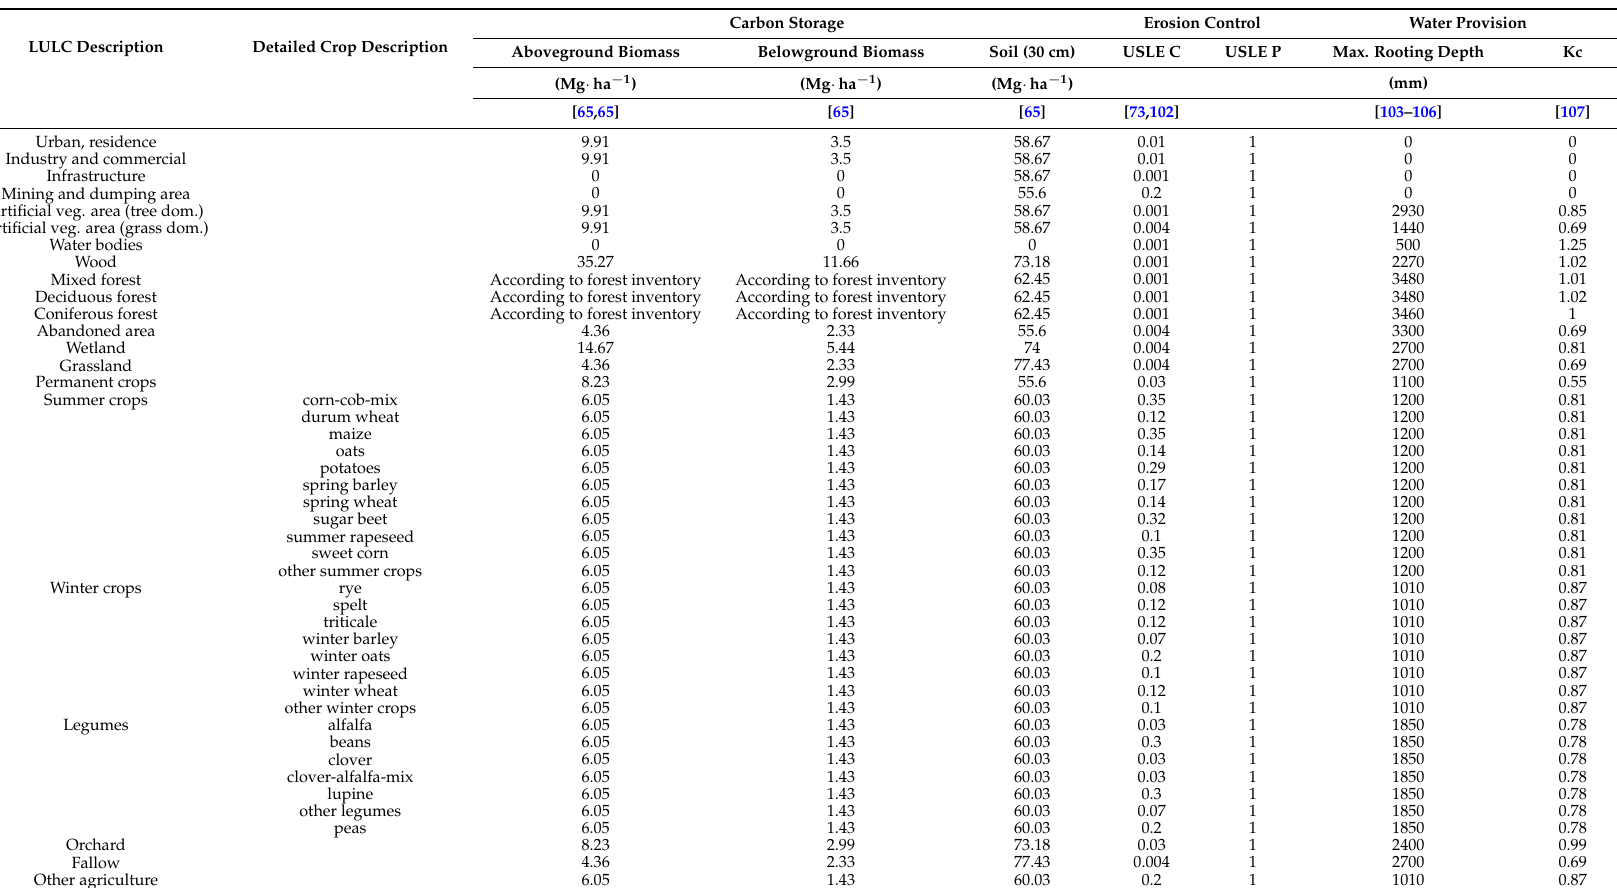
Table A1. Biophysical table with input parameter to model carbon storage, sediment retention and water yield: Carbon stock estimates for above- and belowground biomass and soil to 30 cm depth; land cover management factor C, supporting practice factor P, maximal rooting depth and evapotranspiration coefficients